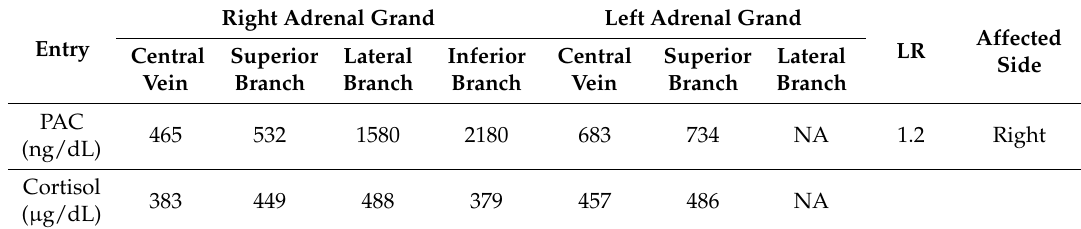
Table A2. Results of adrenal venous sampling of a 48-year-old male patient with APmicroA a